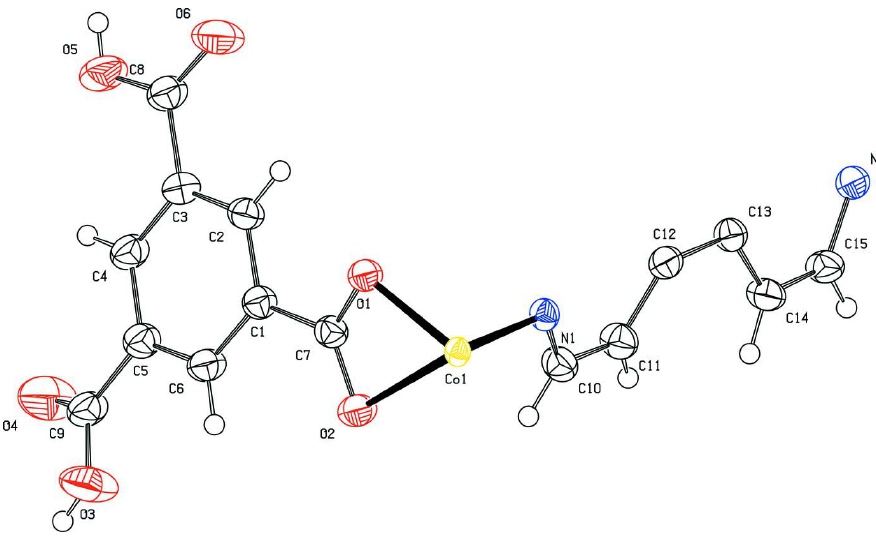
Figure 1 Asymmetric unit of (I), showing displacement ellipsoids at the 50% probability level for the non-hydrogen atoms.